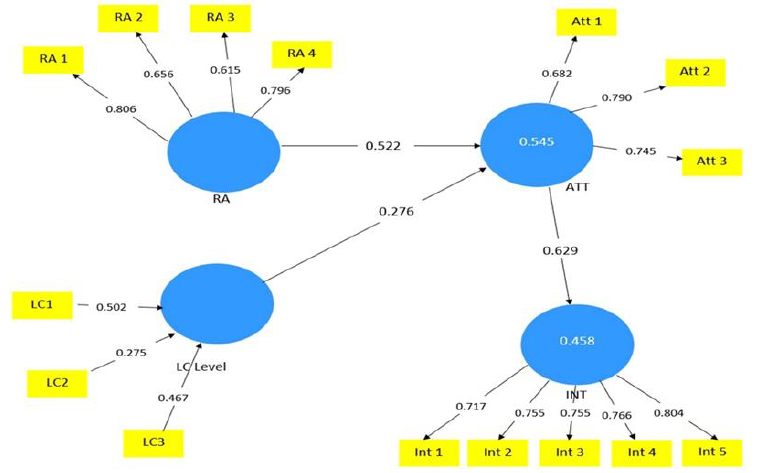
Figure 4. TAM framework considered in the study.